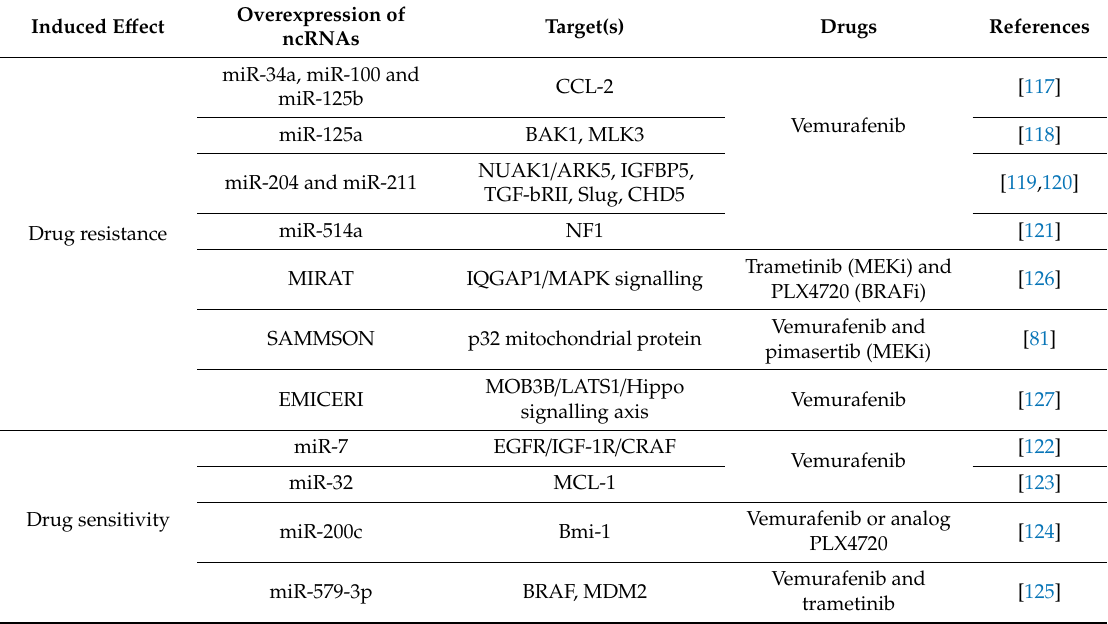
Table 1. Non-coding RNAs that contribute to resistance or sensitivity to targeted therapy with BRAF or MAPK inhibitors.